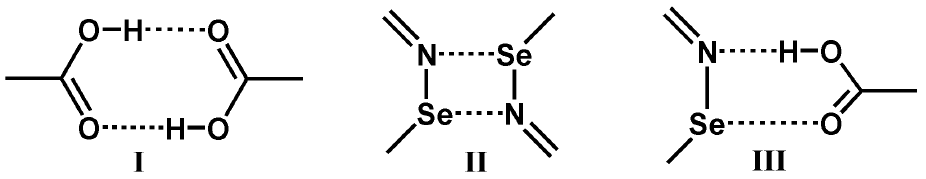
Figure 1. The [COOH] 2 cyclic homosynthon I , [Se − N] 2 cyclic homosynthon II and [COOH]···[Se − N] cyclic heterosynthon III .